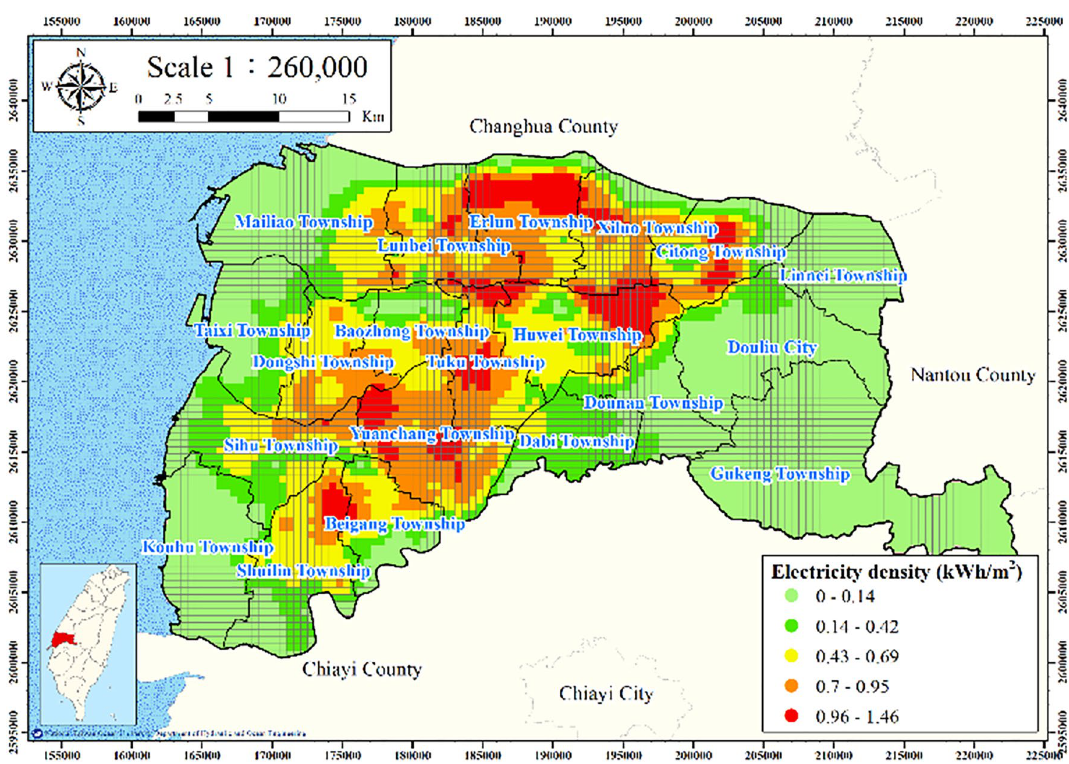
Figure 12. Cells of electricity consumption of wells per square meter. This figure was created using ArcGIS 10.6.1